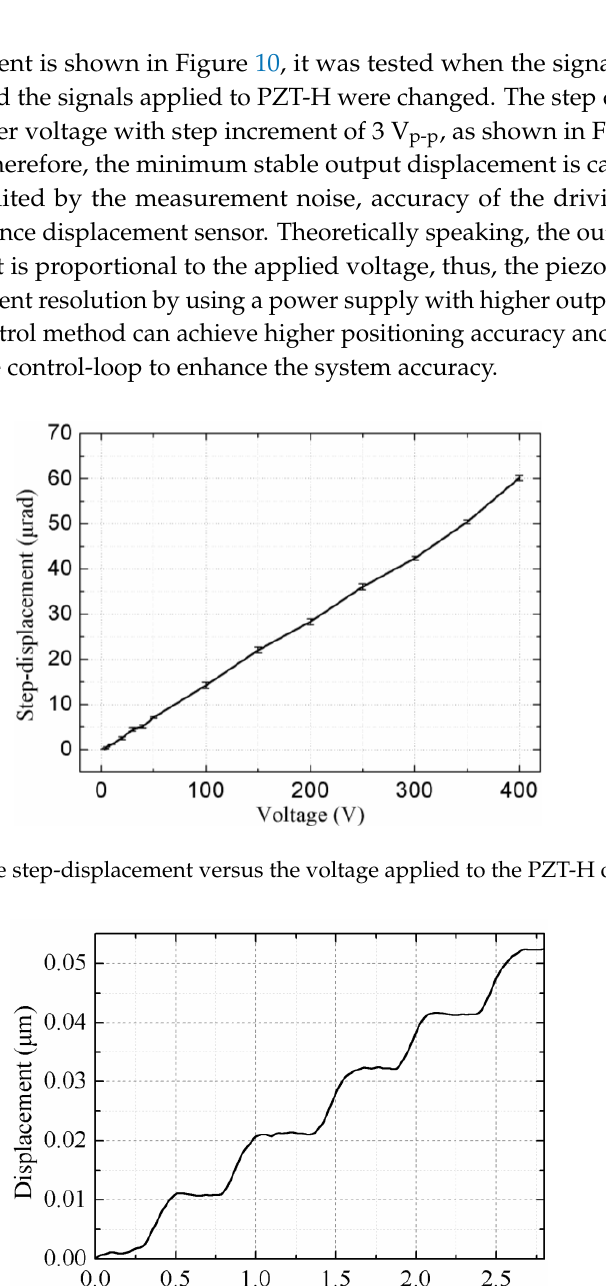
Figure 12. Plot of the speed versus the torque.